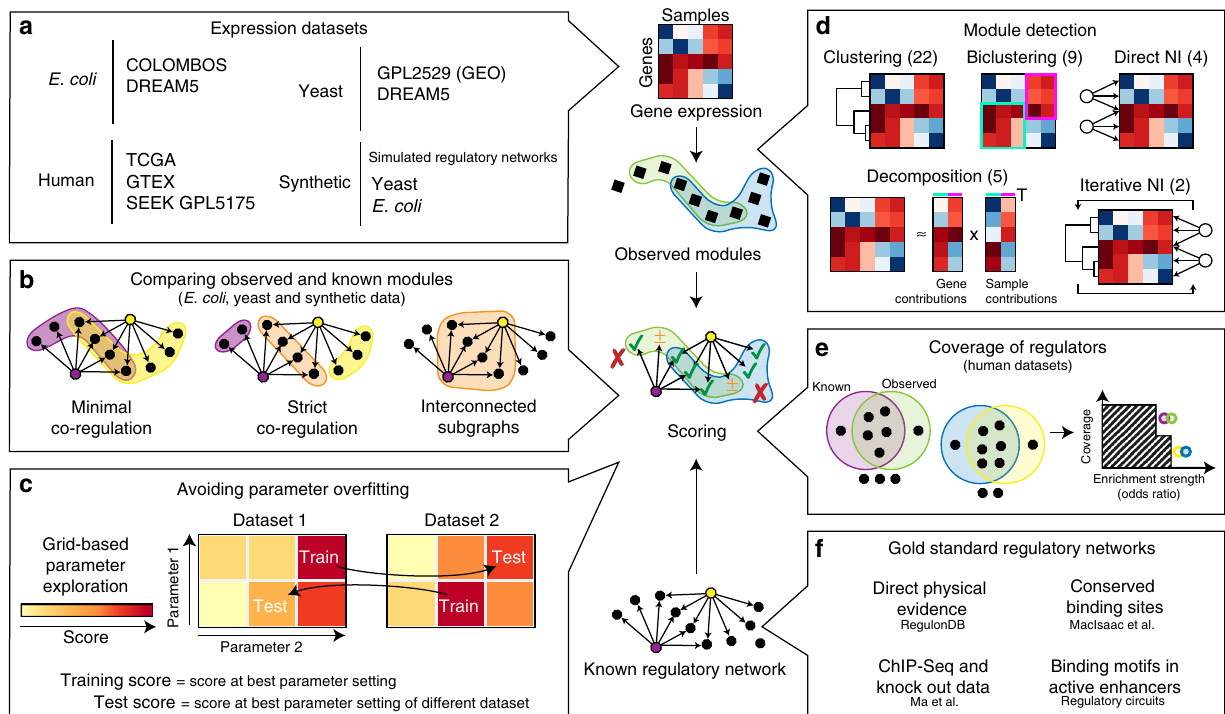
Fig. 1 Overview of our evaluation methodology. a The nine different datasets used in this evaluation. b We used three different module de fi nitions to extract known modules from known regulatory networks for the evaluation on E. coli , yeast and synthetic data. c To avoid parameter over fi tting on characteristics of particular datasets, we fi rst optimized the parameters on every dataset using a grid search, and then used the optimal parameters on one dataset (training score) to assess the performance of a method on another dataset (test score). d We evaluated a total of 42 methods, which can be classi fi ed in 5 categories: clustering, biclustering, direct network inference (NI), decomposition, and iterative NI. e For the evaluation on human data, we compared how well the targets of each regulator is enriched in at least one of the modules. f We used four different regulatory networks in our evaluation, each generated from different types of